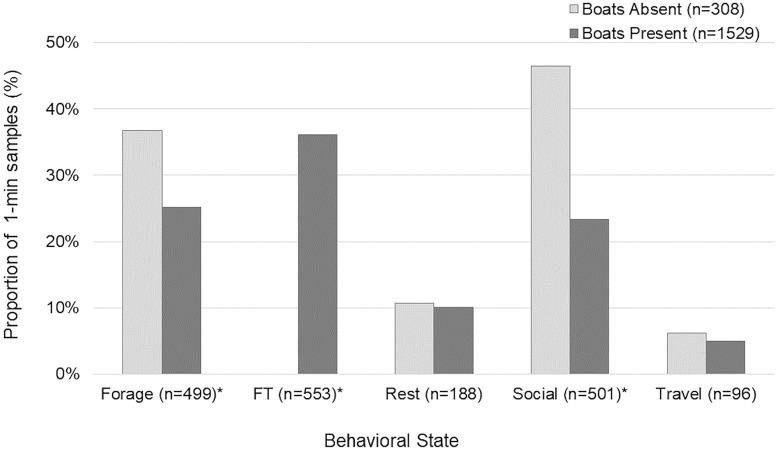
Bottlenose dolphin behavioral activity states based on vessel presence.Asterisks indicates statistically significant differences.